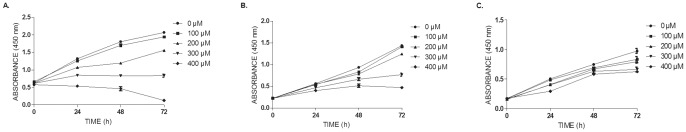
The viability of cells after I3C treatment.The viability of nasopharyngeal carcinoma cells 5-8F, CNE2 and human bronchial epithelial cells 16HBE were detected by CCK-8 assay. (A,B) The proliferation of 5-8F and CNE2 cells were inhibited by I3C in a dose- and time-dependent manner. (C)The proliferation of 16HBE cells were not inhibited by I3C.